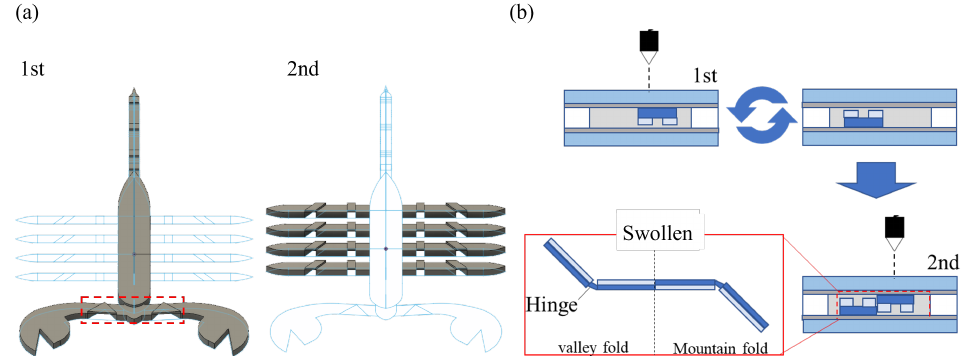
Figure 9. The 4D printing of the scorpion model. ( a ) The two-step method of 3D printing of the scorpion. In the first step, the body and scissor parts are 3D printed. In the second step, the previously printed body and scissors are flipped over and then the eight legs are 3D printed. ( b ) The actual 3D printing process. After the first step of 3D printing, the silicone mold is turned over and the part to be made in the second step is 3D printed from the opposite side. This enables the 4D printing of both valley and mountain folds as in